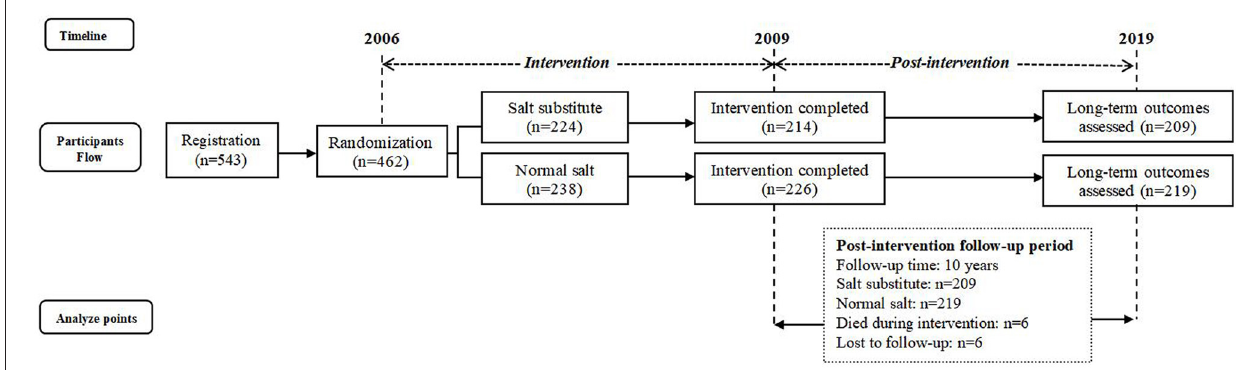
FIGURE 1 | Flow diagram of study design and participant follow-up.